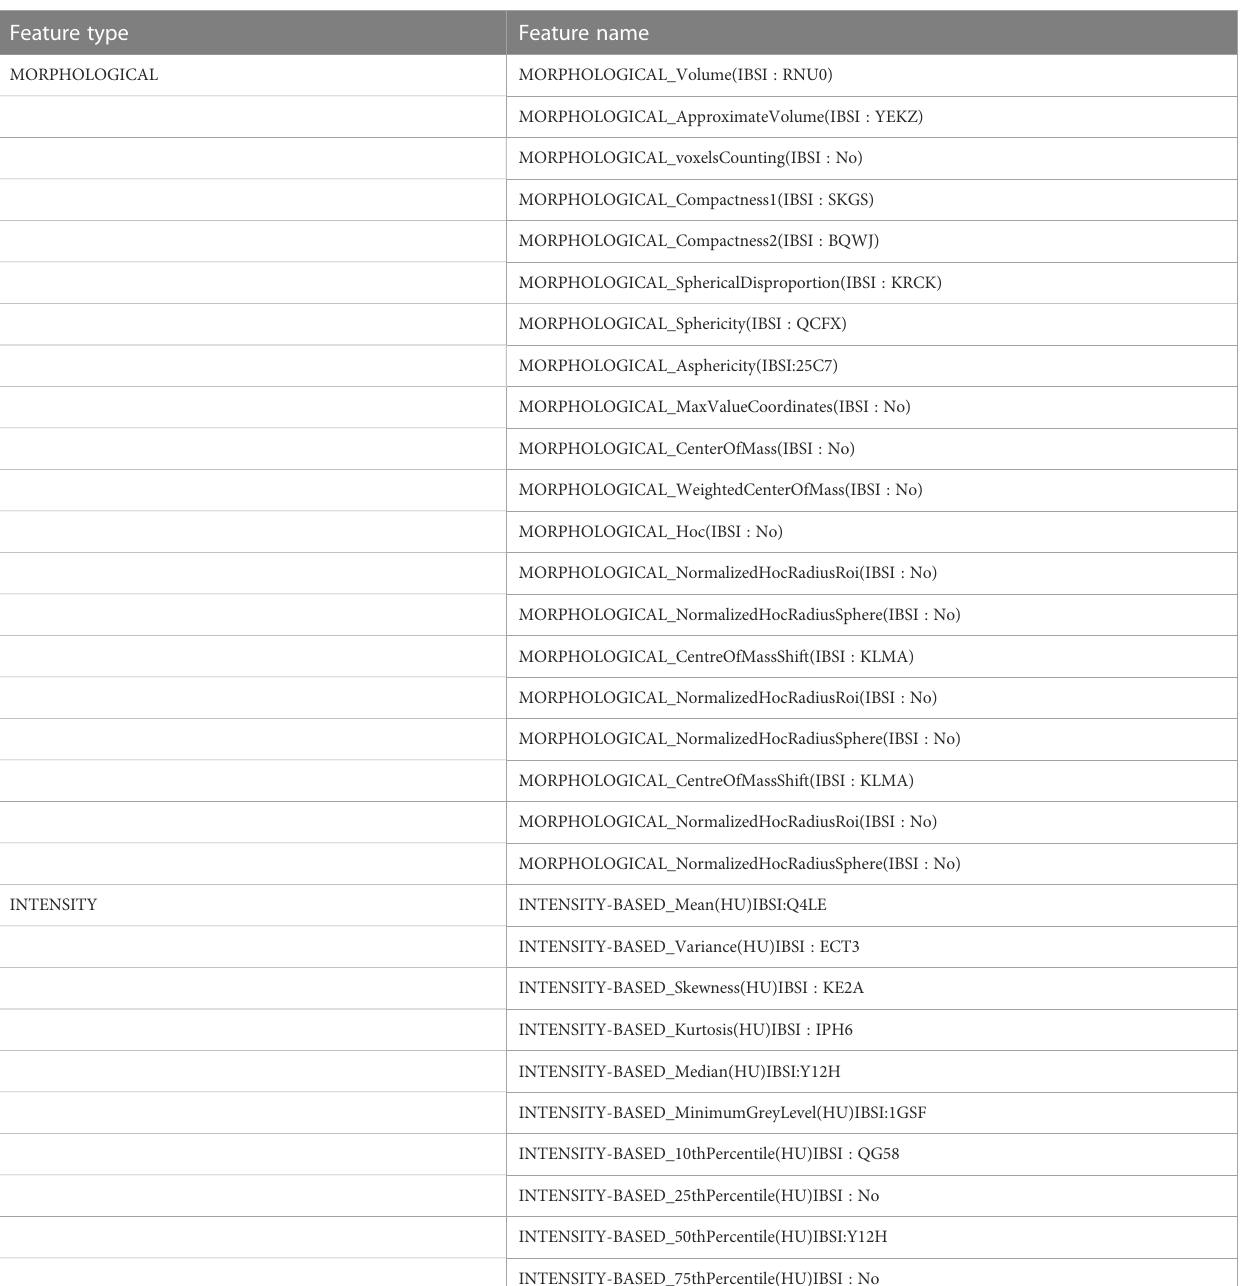
TABLE 1 The extracted features using LIFEx